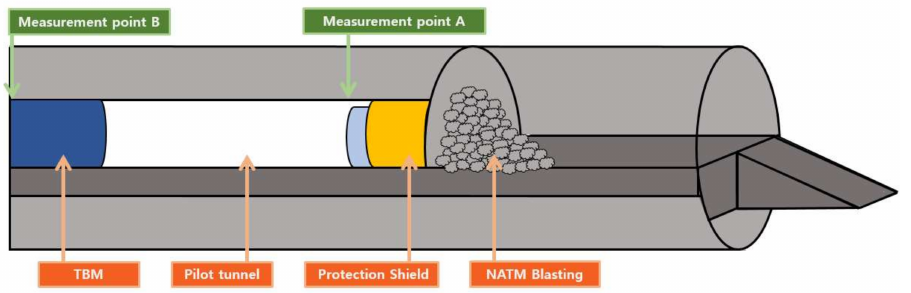
Figure 3. Measurement points A and B.